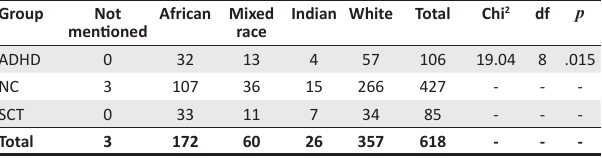
TABLE 5: Race distribution in the three